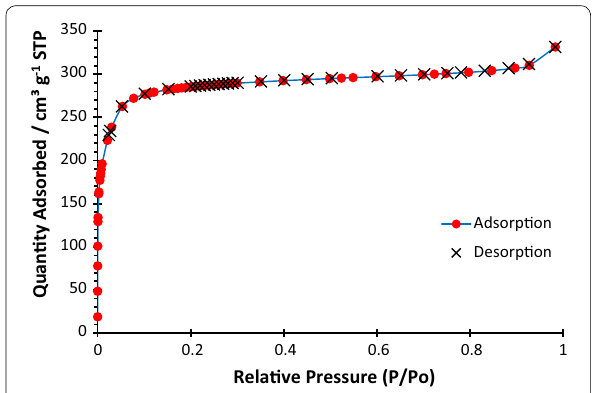
Fig. 5 BET surface area measurement of Zr-MOF-NH 2 at 77 K